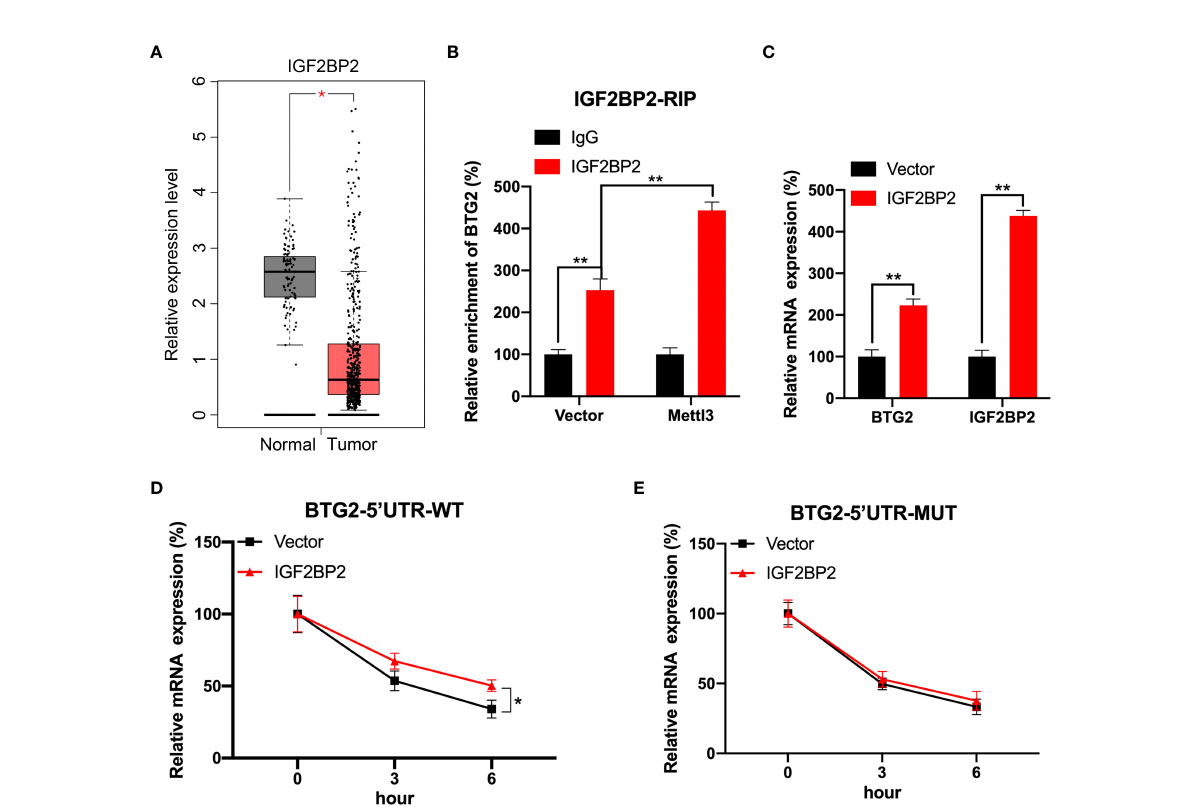
FIGURE 4 IGF2BP2 involved in m 6 A-regulated expression of BTG2. (A) An analysis of IGF2BP2 expression level in RCC tumor tissues (red plot) and normal tissues (grey plot) is shown in the box plot below based on TCGA database. (B) An analysis of BTG2 mRNA in control or Mettl3-overexpressing 786O cells using IGF2BP2 RIP-qPCR. (C) The expression levels of BTG2 and IGF2BP2 in control or IGF2BP2-overexpressing 786O cells using RT-qPCR. D-E. The mRNA expression levels of pmirGLO-BTG2-5 ’ UTR-WT (D) or pmirGLO-BTG2-5 ’ UTR-MUT (E) in 786O cells after overexpressing IGF2BP2 and treatment with ActD for indicated times. * P<0.05, **